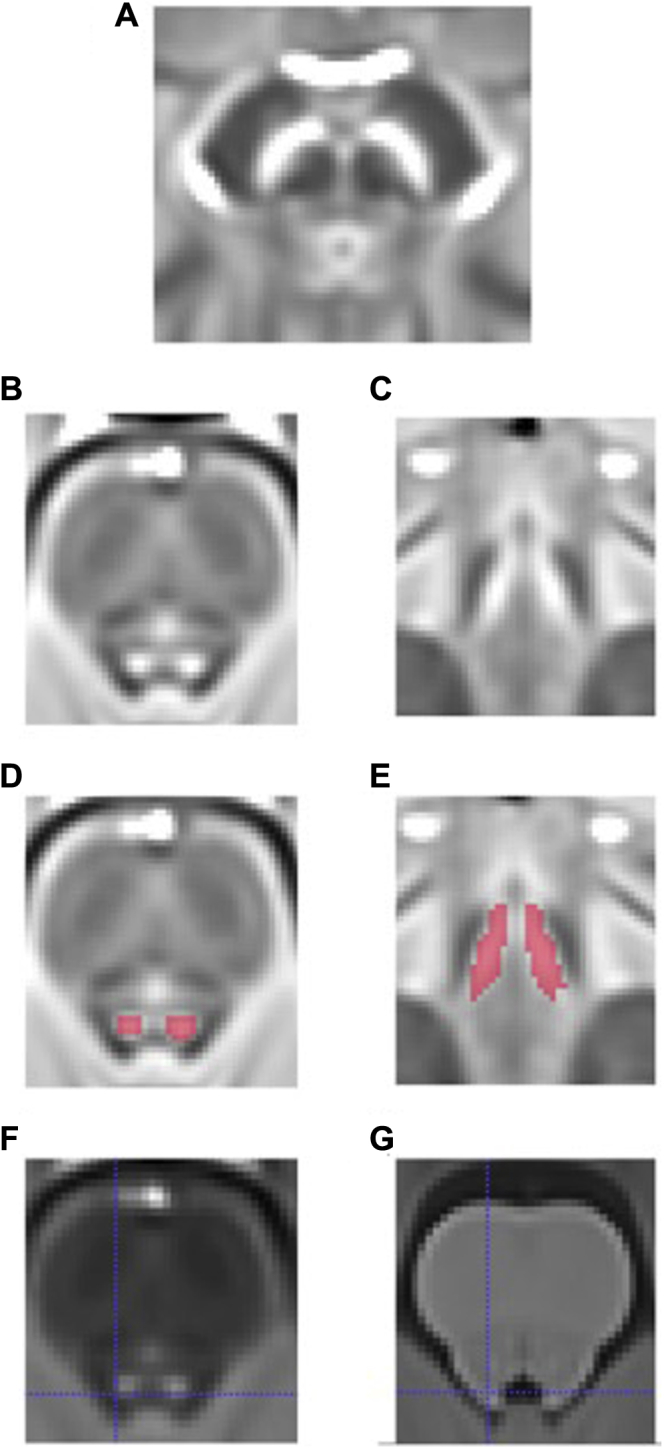
Cam-CAN MT-weighted group template images showing LC (axial B,D, coronal C,E) with LC segmentations (D,E in red). A multivariate template approach was used to create an MT-weighted (F) and T1-weighted (G) group image. The substantia nigra could be visualized on the MT-weighted group template (A). In (B) and (F), two areas of signal hyperintensity are visible which correspond to the neuroanatomical positions of right and left LC in the lateral floor on the 4th ventricle in (G). The left LC can be seen at the crosshair in (F) and its position in (G) is indicated by the corresponding crosshair. Segmentation of these areas was performed on the axial slices on the MT-weighted template (D). The substantia nigra, a region with similar macromolecular properties to the LC, could also be visualized as two areas of signal hyperintensity on the MT-weighted group template (A). Abbreviations: LC, locus coeruleus; Cam-CAN, Cambridge Centre for Ageing and Neuroscience; MT, magnetization transfer. (For interpretation of the references to color in this figure legend, the reader is referred to the Web version of this article.)